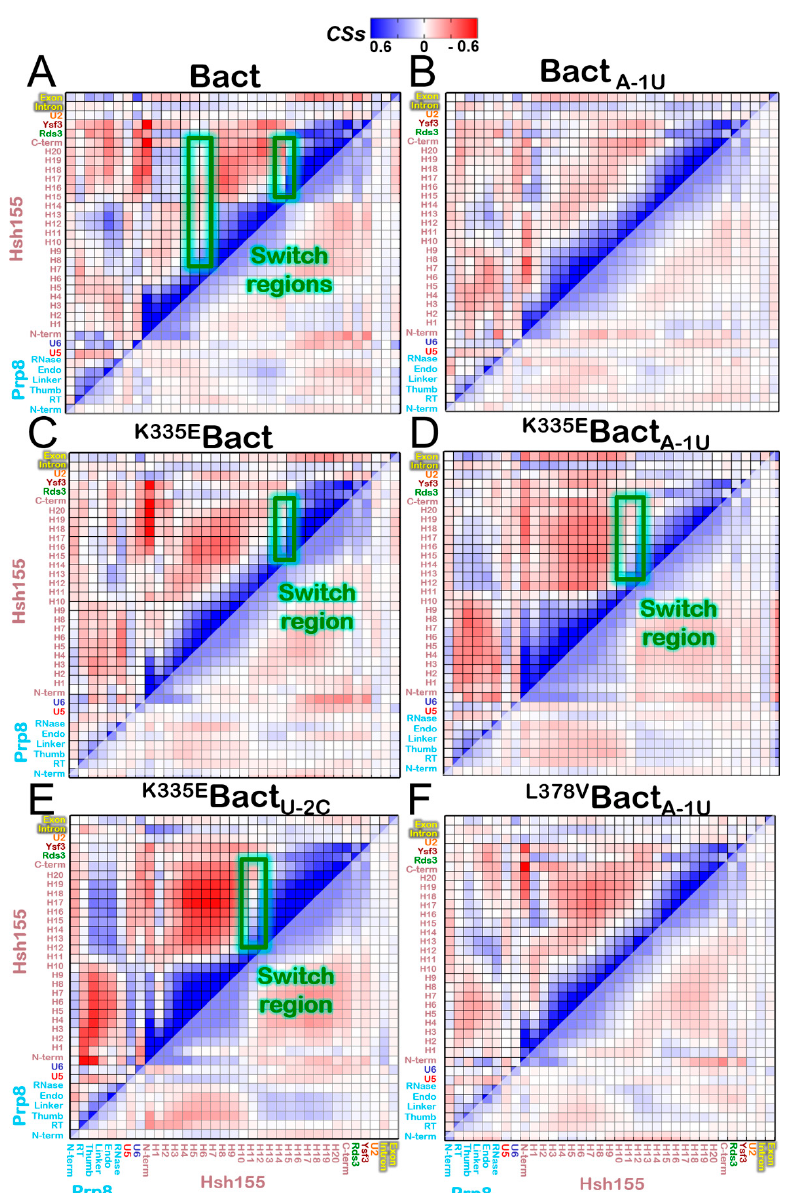
Figure 3. Cooperative motion underlying the functional dynamics of the distinct Bact models investigated. Per-residue Pearson’s coefficients (CCs) cross-correlation matrix is derived from the mass-weighted covariance matrix calculated over the last 500 ns of classical molecular dynamics trajectories. CCs values range from -1 (red, anti-correlated motions) to +1 (blue, correlated motions) are summed for each pair of considered spliceosome (SPL) proteins/domains, and normalized to provide density correlation scores (CSs). No cutoff has been applied here on the CCs selection. Instead, CSs are reported in the range from − 0.6 to 0.6 for clarity reasons. We remark that, with this choice, there are elements out of the range (i.e., the element with value =1.0 has the same color as that with 0.6). The Hsh155 is split by HEAT (huntingtin elongation factor 3 protein phosphatase 2A, target of rapamycin 1)-repeats and Prp8 is divided by domains. In green are encircled the Hsh155 regions where a switch between a positive and a negative correlation occurs. Depicted are CSs of ( A ) Bact , ( B ) Bact A-1U , ( C ) K335E Bact , ( D ) K335E Bact A-1U , ( E ) K335E Bact U-2C , and ( F ) L378V Bact A-1U models. Bact models are labeled reporting the Hsh155 and BPS mutations as left superscript and right subscript, respectively. Protein names and their domains are labelled on the bottom and left of the